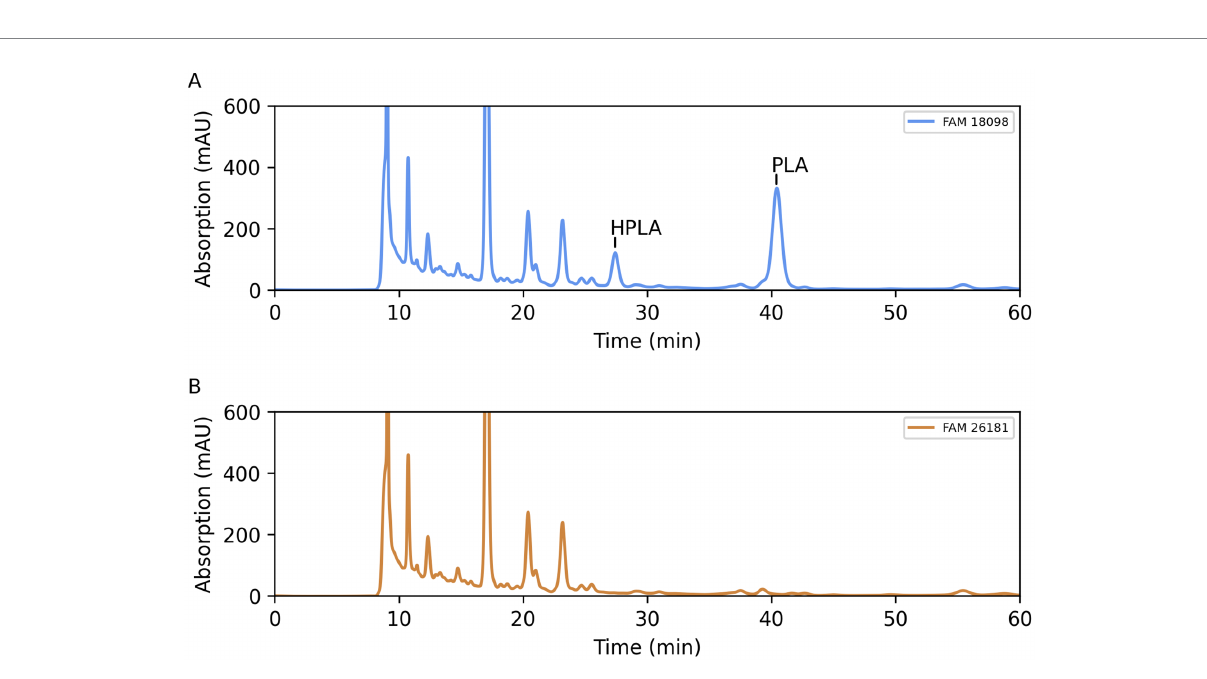
FIGURE 4 Organic acid profile of culture supernatants of wild-type strain FAM 18098 (A) and of aat knockout strain FAM 26181 (B) after incubation for 3 days in MRS medium. PLA: 3-phenyllactic acid, HPLA: 4-hydroxyphenyllactic